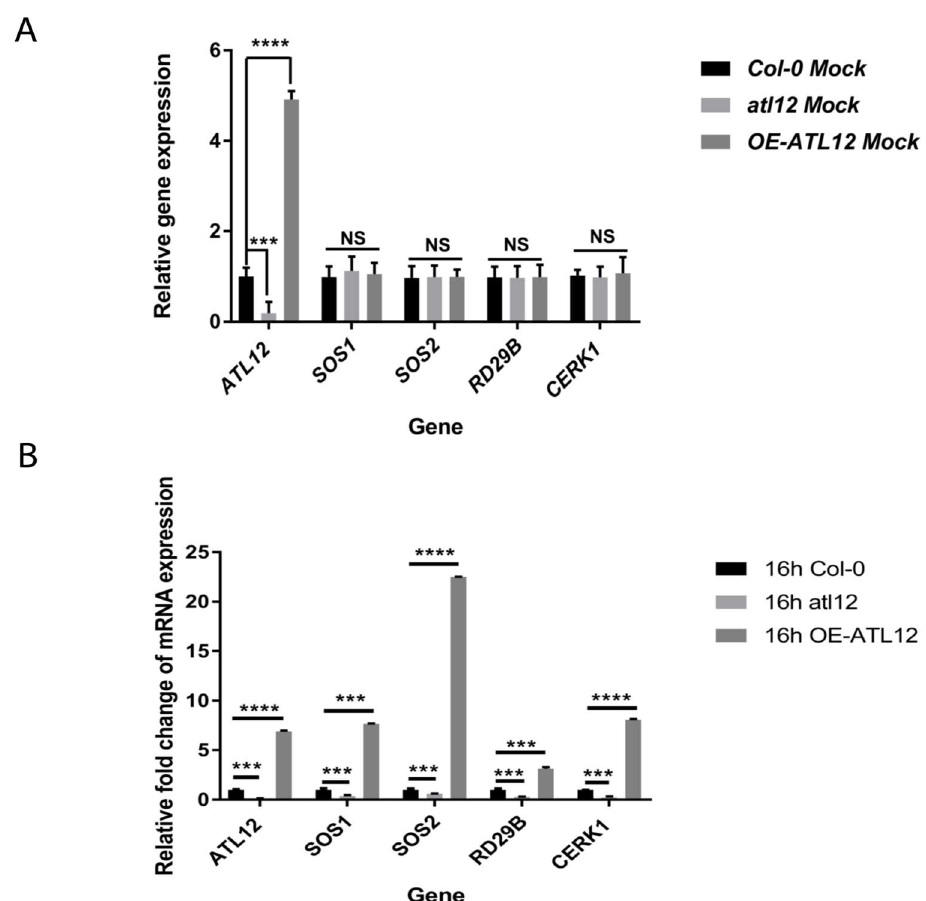
Figure 4. qRT-PCR analysis of ATL12 , SOS1 , SOS2 , RD29B , and CERK1 expression in Col-0 , atl12 , and OE-ATL12 under normal conditions and salt stress. ( A ) qRT-PCR analysis of salt responsive genes under normal conditions; ( B ) qRT-PCR analysis of salt responsive genes in response to salt. Asterisks indicate statistically significant differences between the samples, according to the One-way ANOVA analysis and multiple comparison post Tukey’s test. **** indicates p < 0.0001, *** indicates p < 0.001, and NS indicates not significant. The black line indicates that significant differences are present between datasets. The error bar indicates means ± the SD of three independent biological